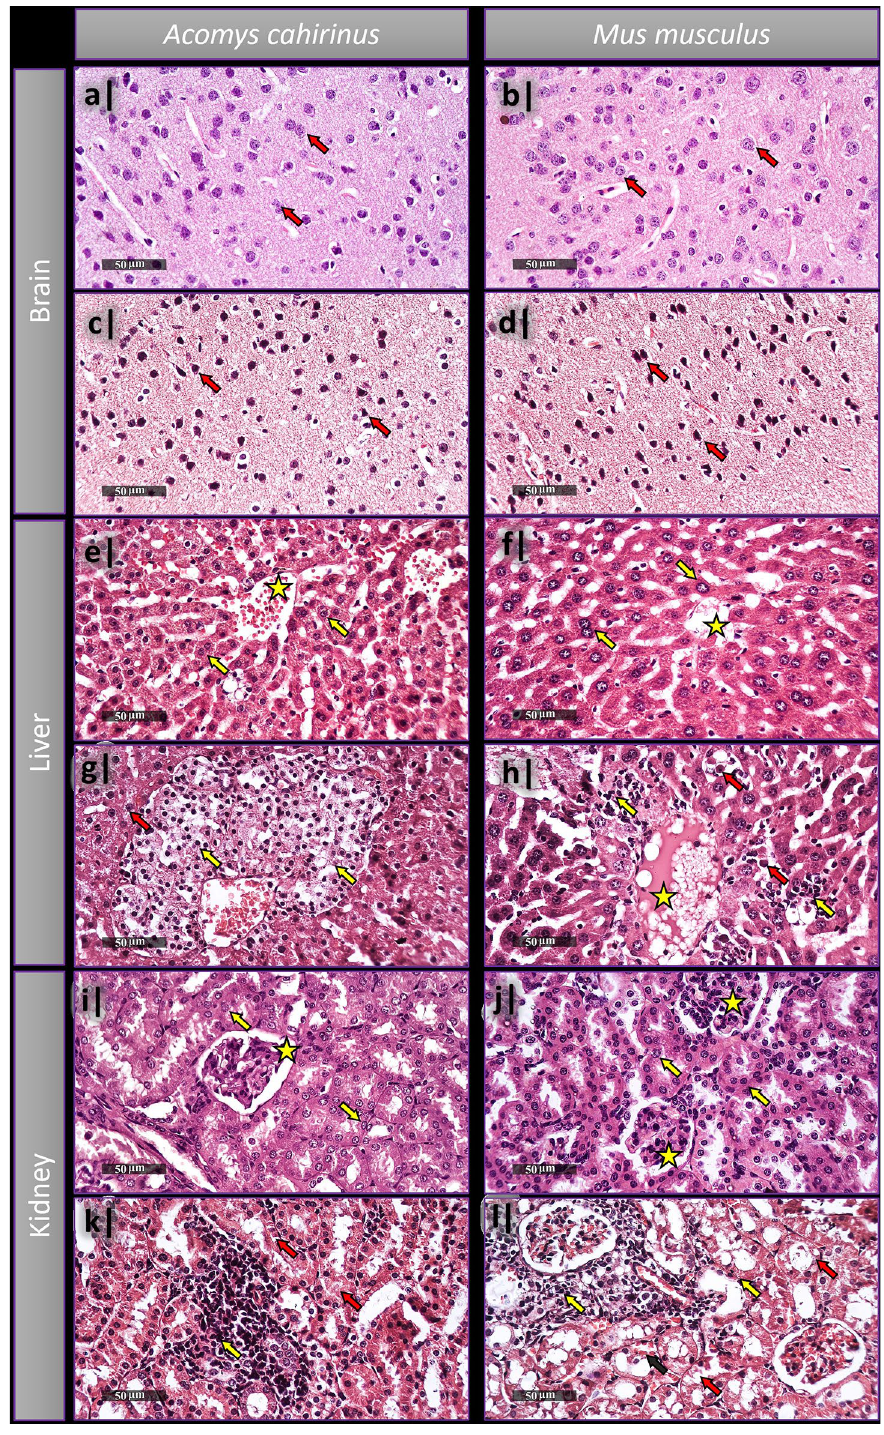
Figure 6. Histopathological examination of brain ( a–d ), liver ( e–h ), and kidneys ( i–l ) of Acomys cahirinus and Mus musculus treated with 50 mg/kg LA for 5 consecutive days. ( a,b ) Brain cortical region of Acomys ( a ) and Mus ( b ) shows intact nuclear details (red arrows). Both treated groups of Acomys ( c ) and Mus ( d ) show severe neuronal degenerative changes all over the cortical layers accompanied with multiple angular pyknotic structureless cell bodies (red arrows) in addition to severe vacuolization of brain matrix. ( e,f ) Normal control liver samples of Acomys ( e ) and Mus ( f ), both show intact subcellular details of hepatic tissues (yellow arrows) and hepatic vasculatures (yellow star). ( g ) Treated Acomys group sample shows severe vacuolar degenerative changes of hepatocytes (red arrow) with pyknotic nuclei (yellow arrows) all over hepatic lobules. ( h ) Treated Mus group sample shows severe dilatation hepatocytes (yellow star) with perivascular inflammatory cell filtrates (yellow arrows) and apoptotic bodies formation (red arrows). ( i,j ) Normal control kidneys samples of Acomys ( i ) and Mus ( j ) show the intact renal corpuscles (yellow stars) and tubular epithelium (yellow arrows). ( k ) Treated Acomys kidney samples show mild records of degenerated tubular epithelium (red arrows) with occasional periglomerular inflammatory cells infiltrates (yellow arrow) compared with the more severe records of the degenerated tubular epithelium in the Mus ( l ) (red arrow), more congested blood vessels (black arrow), and occasional periglomerular inflammatory cell infiltrates (yellow